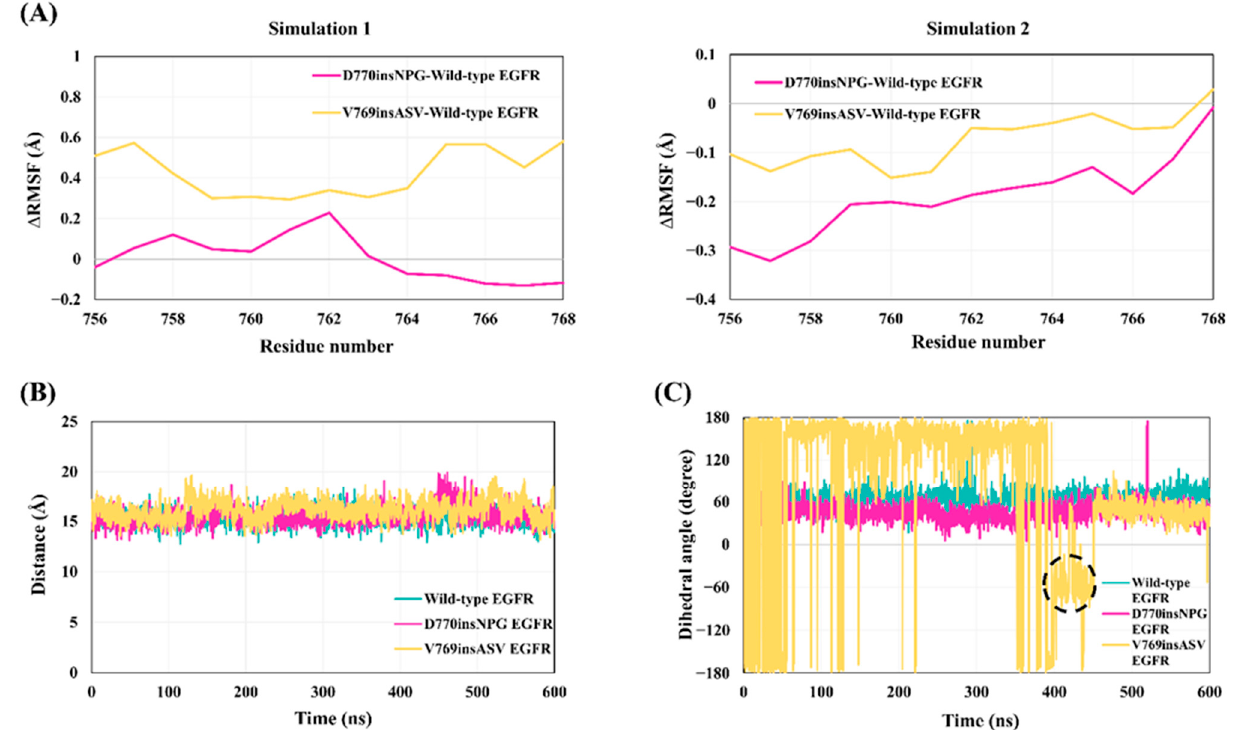
Figure 10. Stability of the α C helix, the broken-state of the Lys745–Glu762 salt bridge and conformation of Phe856 of the DFG motif in the wild-type and mutant inactive EGFRs. ( A ) RMSF difference between residues of the α C helix from the wild-type and insertion mutant EGFRs in simulation 1 (left) and 2 (right). ( B ) Distance between the side-chain atom N ζ of Lys745 and C δ of Glu762; the salt bridge did not form during the simulations. ( C ) The χ 1 torsion angle of Phe856 of the DFG motif. The wild-type and D770insNPG EGFRs strictly maintain the inactive state conformation of Phe856 throughout the 600 ns simulation, whereas the V769insASV EGFR visits the active state conformations between 400 and 450 ns of the simulation (encircled).